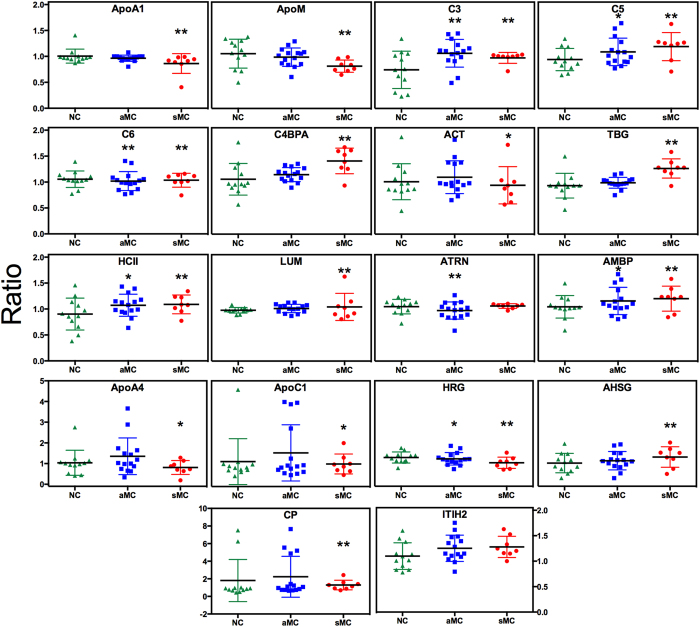
Ratios of differentially abundant proteins.Mean ratios and standard deviations of plasma proteins from noncarriers (NC), asymptomatic (aMC) and symptomatic mutation carriers (sMC) relative to reference masterpool as quantified by iTRAQ. All 18 proteins differed significantly in abundance in a global comparison of NC, aMC and sMC groups (Table 2). Ratios that significantly differed from the NC group in pairwise comparisons are marked with asterisks (*p < 0.05/2 compared to NC; **p < 0.01/2 compared to NC). ApoA1, Apolipoprotein A-I; ApoM, apolipoprotein M; C3, complement component C3; C5, complement component C5; C6, complement component C6; C4BPA, C4-b binding protein α chain; ACT, α-1-antichymotrypsin; TBG, thyroxine-binding globulin; HCII, heparin cofactor II; LUM, lumican; ATRN, attractin; AMBP, protein α-1-microglobulin/bikunin precursor; ApoA4, apolipoprotein A-IV; ApoC1, apolipoprotein C-I; HRG, histidine-rich glycoprotein; AHSG, α-2-HS-glycoprotein; CP, ceruloplasmin; ITIH2, inter-α-trypsin inhibitor heavy chain H2.